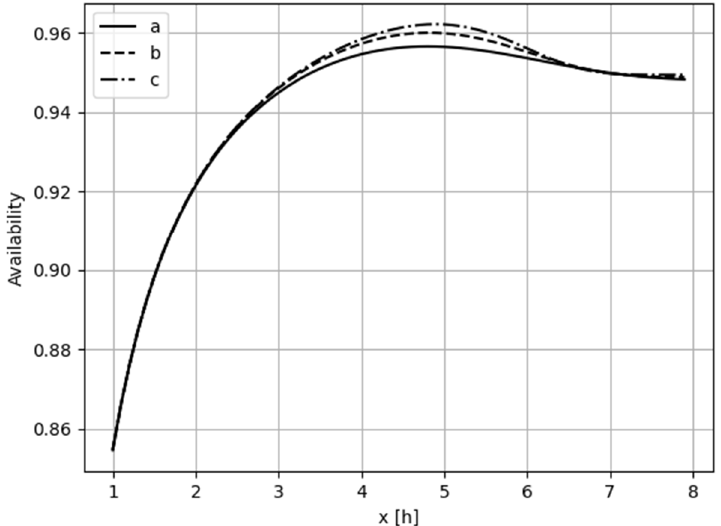
Figure 3. Graphs of the function g(x)—availability to perform transport tasks as a function of time to preventive replacement x [h], determined for a Weibull distribution with parameter values scale = 6 and shape = 5 (curve a), shape = 7 (curve b), shape = 9 (curve c).